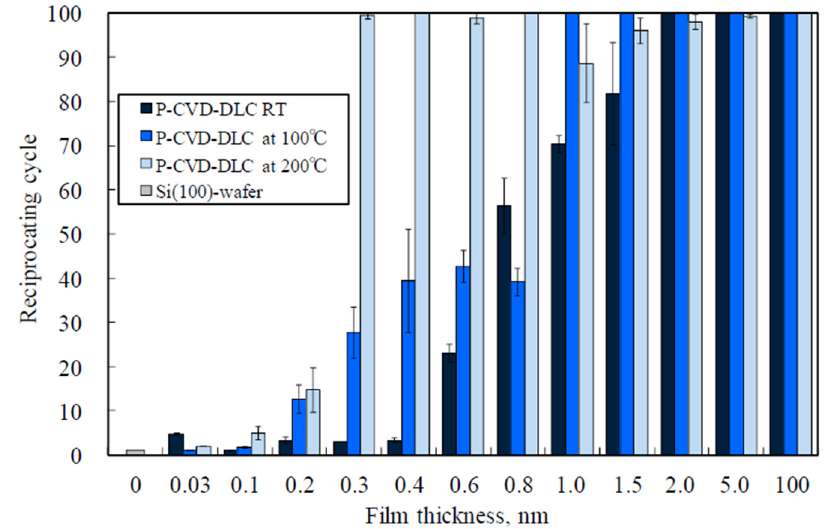
Figure 10. Endurance reciprocating cycle of P-CVD-DLC films at various temperatures.